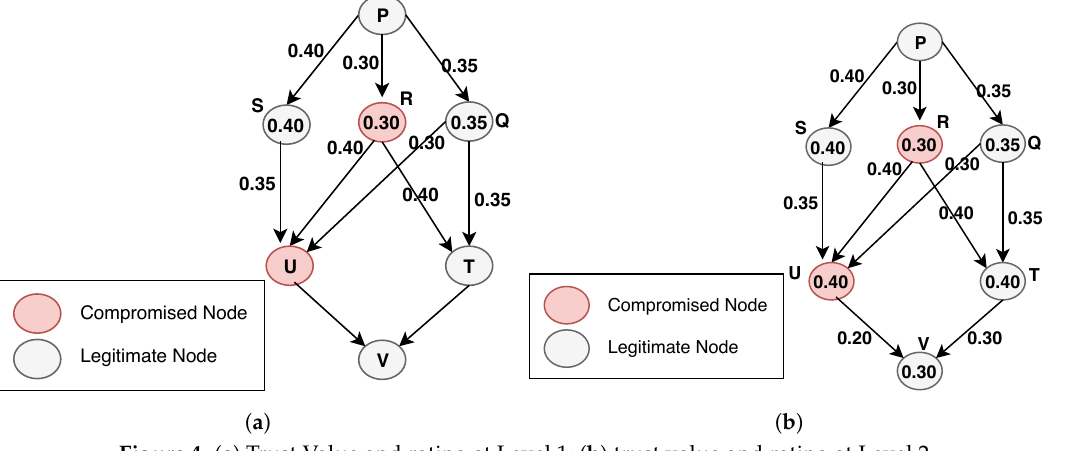
Figure 4. ( a ) Trust Value and rating at Level 1; ( b ) trust value and rating at Level 2. Algorithm 1: Computation of the rating and TF/TV of all CNs. Assumption: All the cognitive nodes are divided into certain levels (i.e., as depicted in Figure 5: node P is at Level 0, nodes Q, R and S are at level 1, and so